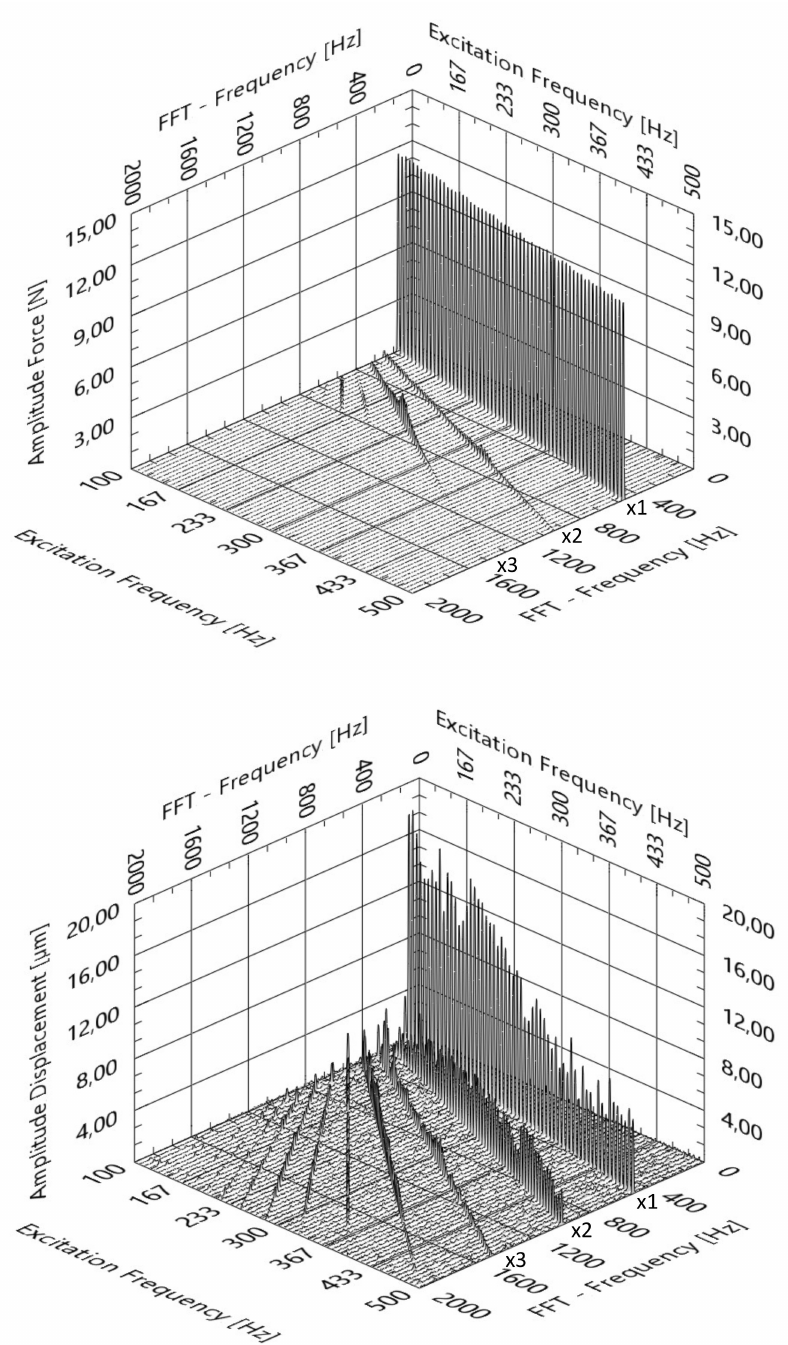
Figure A2. Waterfall plot of force and displacement sensor data in x-direction (11.1 N static load, 12 N force